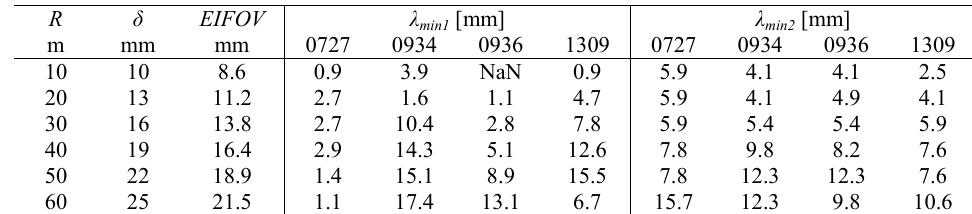
Table 3. Footprint size δ , EIFOV and λ min values for similarity measures 𝑒𝑟𝑟𝑜𝑟 𝑘,𝑗 and std( Δ𝑍 𝑘,𝑗 ) as a function of scanning range R